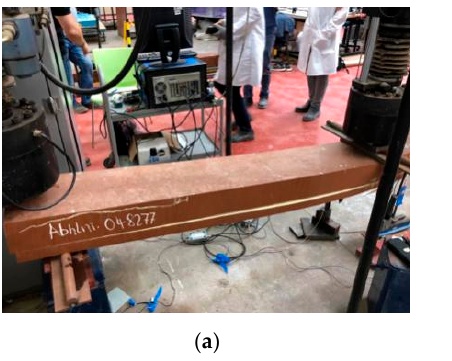
under ( a ) single load test at 132 kN; ( b ) repeated load test at ultimate load (170 kN).